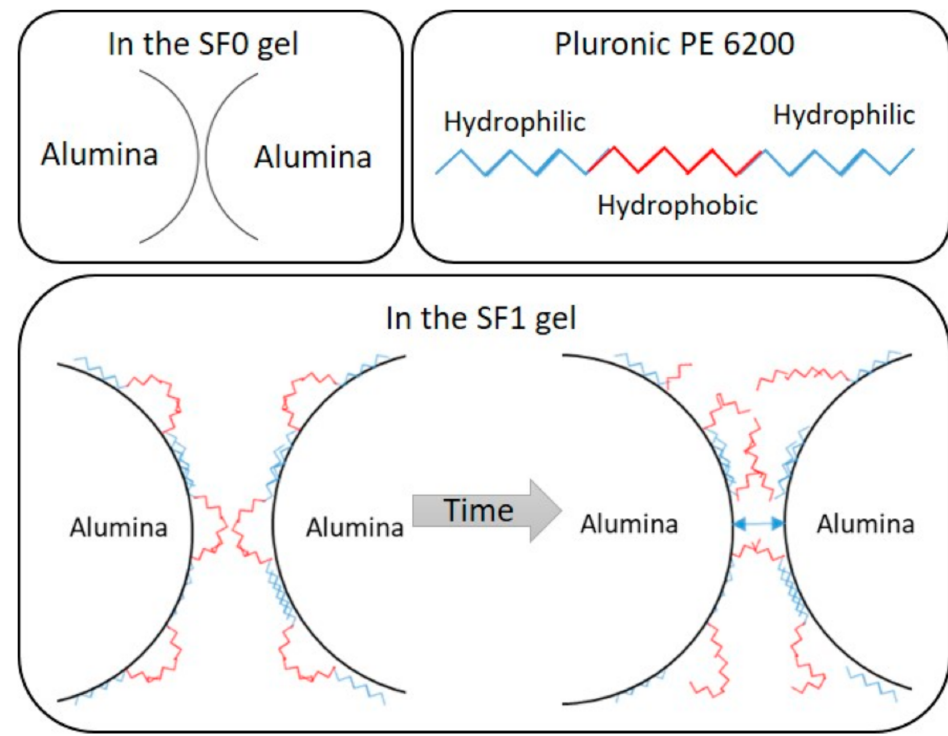
Figure 4. Schematic representation of the alumina–surfactant interaction in the